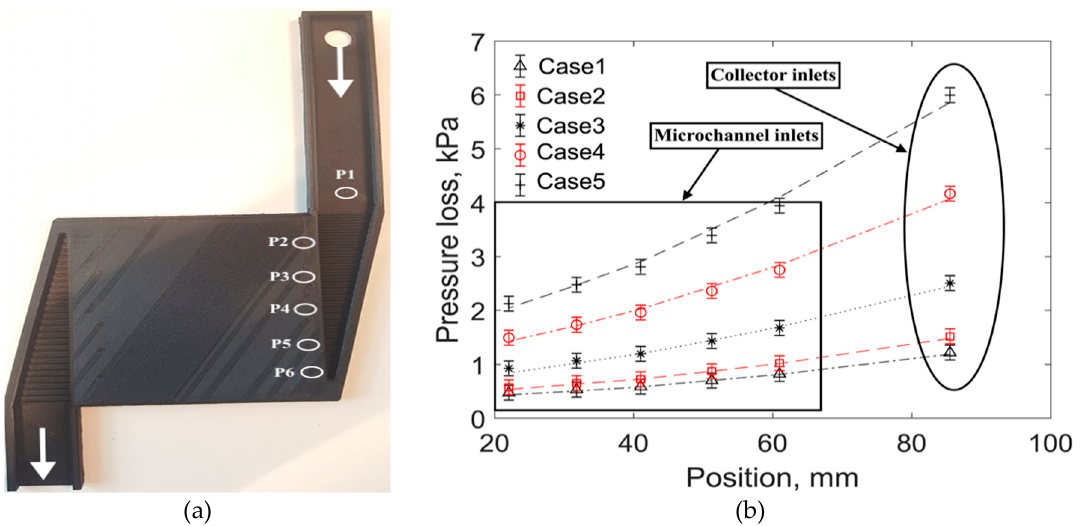
Figure 10. Experimental test design for collector flow maldistribution ( a ); comparison plot between experimental and CFD pressure losses (dashed lines are for the numerical results and symbols are for the experimental readings) ( b ). Table 2. Collector inlet mass flow rates for different cases.